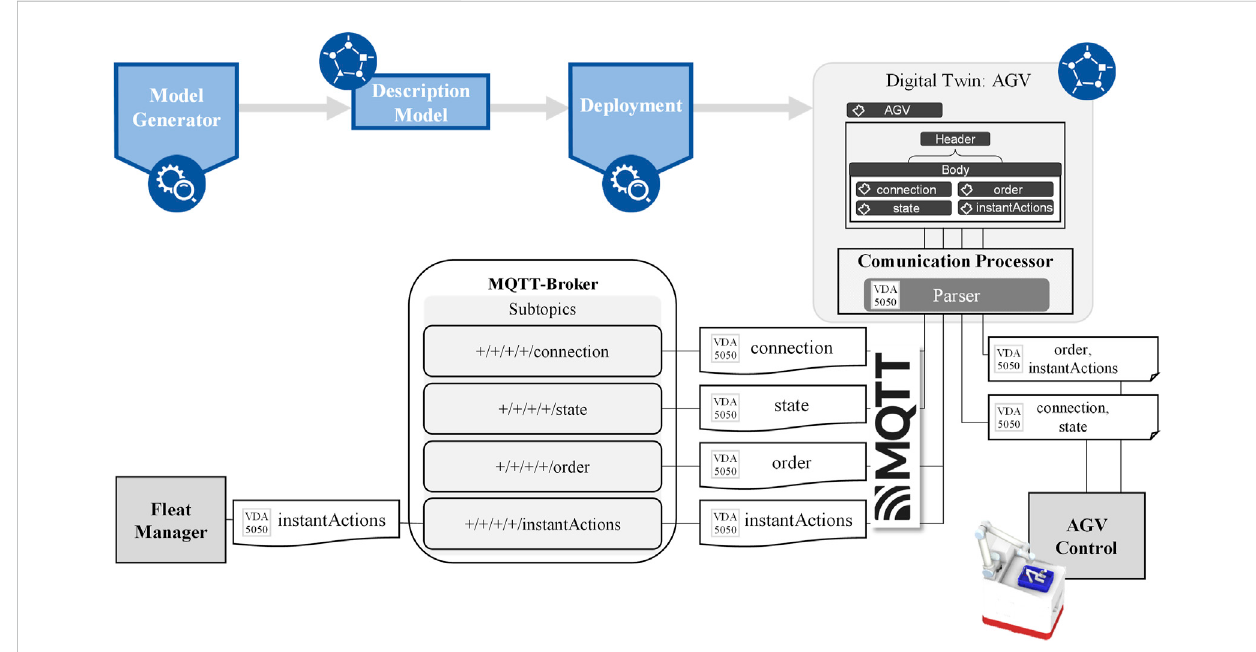
FIGURE 11 Work fl ow of AGV integration following the Digital Twin Pipeline and VDA 5050 speci fi